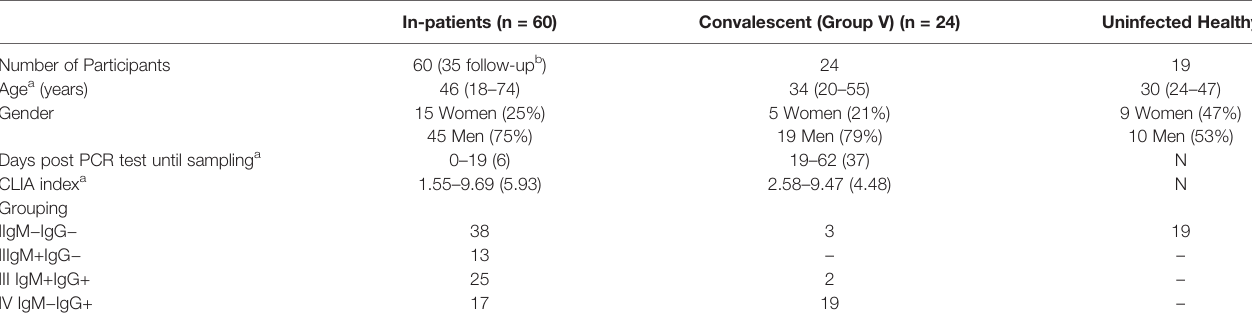
TABLE 1 | Abridged clinical data of study